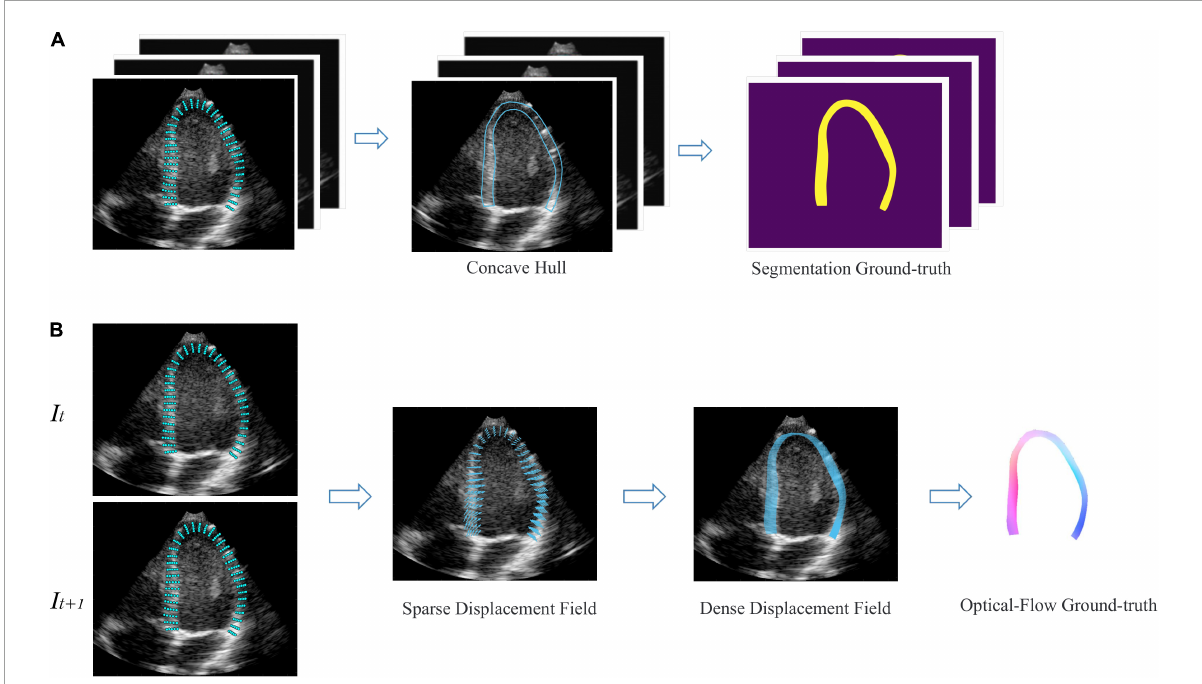
FIGURE3 Semi-automatic data annotation. (A) Segmentation marked, the concave hull formed by connecting the outermost point is marked as the LVM region. All pixels within the hull are marked as “1,” as shown in yellow, and those outside are marked as “0,” as shown in purple. Every three frames as a data. (B) Optical flow marked, I t , I t + 1 represent two adjacent frames. The sparse displacement field is calculated according to the position changes of the corresponding points of the before and after frames. Then, the density velocity field of each pixel is generated by cubic interpolation, which is represented as flow field. Color and saturation indicate direction and magnitude, respectively.